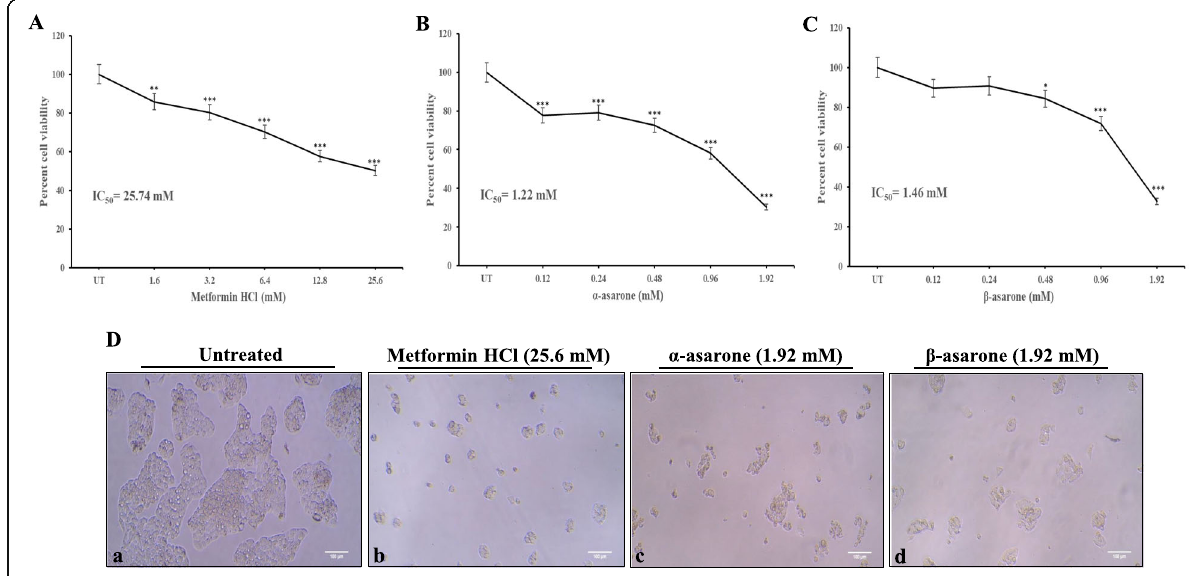
Fig. 1 Metformin and asarone inhibit the growth and modify the morphology of HepG2 cells. A – C Cells were treated with metformin HCl, α - asarone, and β -asarone as indicated for 48 h and the cell viability was determined by MTT assay. D Representative images to show the morphology of HepG2 cells under an inverted microscope. The scale of the bar is 100 μ m. a Untreated group; the morphology of HepG2 cells had a high density with adherent cell colonies, whereas, in the treatment group, metformin HCl (b) and asarone (c, d) at higher concentration showed lower density with a small round body. Values represent mean ± SEM of an experiment done in triplicate; one-way ANOVA followed by Bonferroni test, where * p < 0.05, ** p < 0.01, and *** p < 0.001 compared to the untreated (UT)